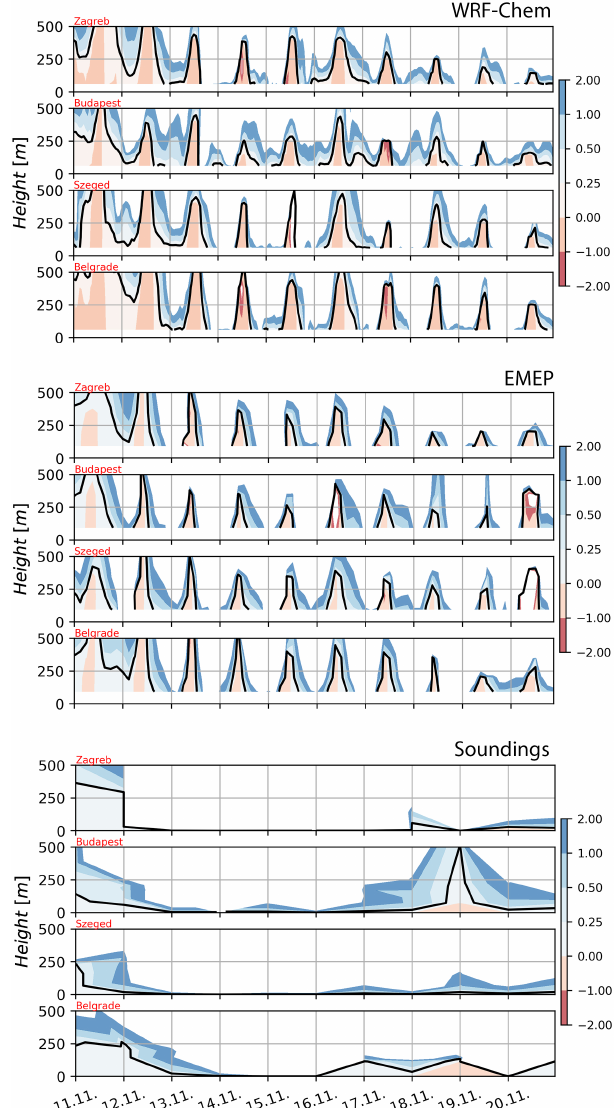
Figure 10. Time series of the vertical profile of the bulk Richardson number (Eq. 9, the colour bar on the right) for the Zagreb, Budapest, Szeged and Belgrade sites from the WRF-Chem and EMEP mod- els and sounding measurements (source: http://www.weather.uwyo. edu/upperair/sounding.html; last access: 12 May 2020) before/after and during second pollution episode (from 11 to 21 November). The black line indicates the boundary layer height ( Ri B = 0 .